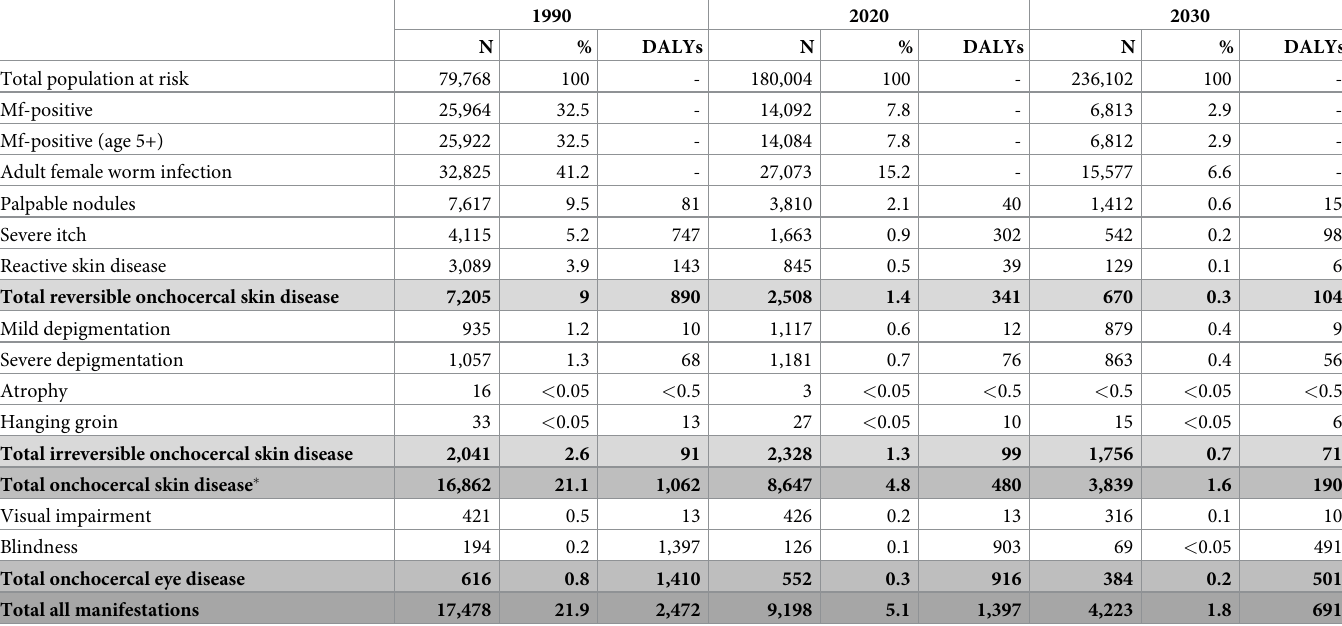
Table 1. Population at risk, total number of cases infected and with clinical manifestations, and DALYs lost due to onchocerciasis for 1990, 2020, and 2030. Abso- lute numbers (N and DALYs) are presented in